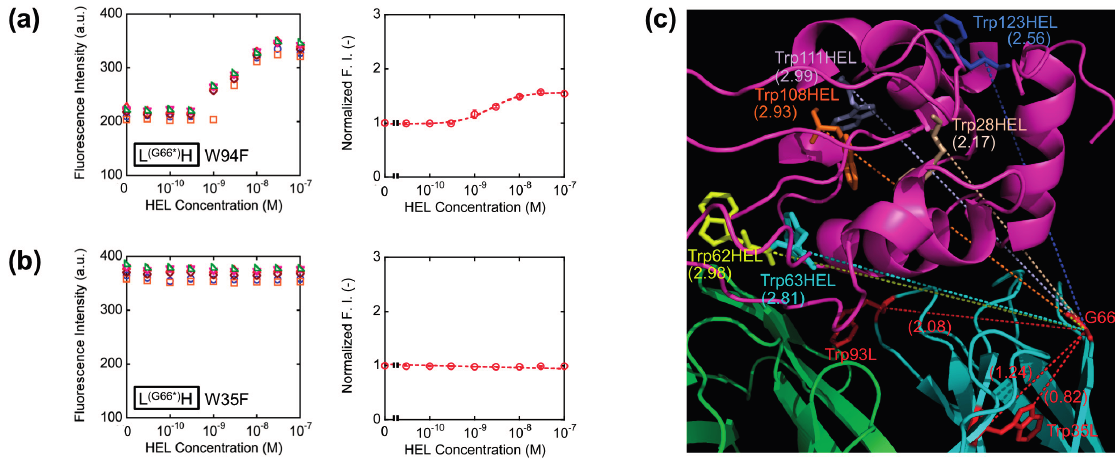
Figure 5. Titration curves for W94F ( a ) and W35F ( b ) mutant of L (G66*) H Q-body. Error bars represent ±1 SD (n = 6); ( c ) Distance from the position 66 to Trp94L, Trp35L, or to the Trp residues in HEL. The C α -C α Trp residues to the position 66 shown in parentheses were measured using PyMOL. The unit of distance is